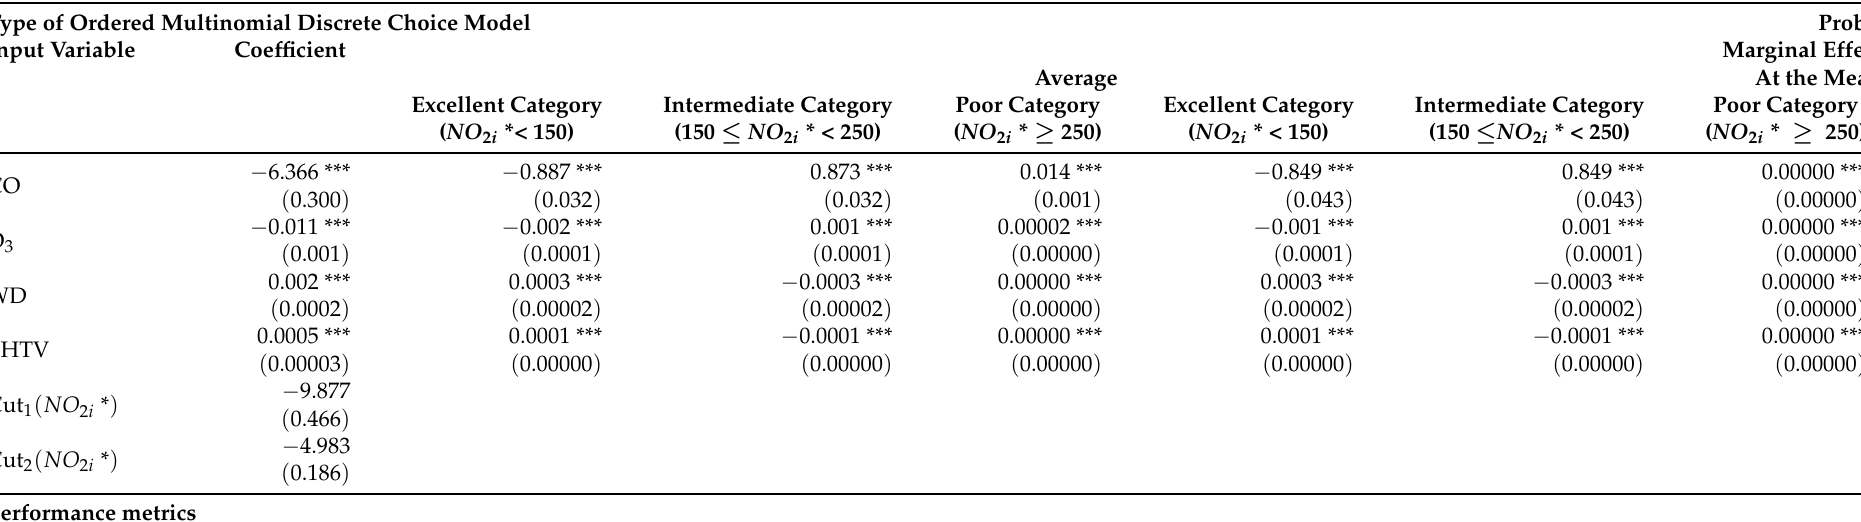
Table 8. Outcomes with ordered multinomial discrete choice